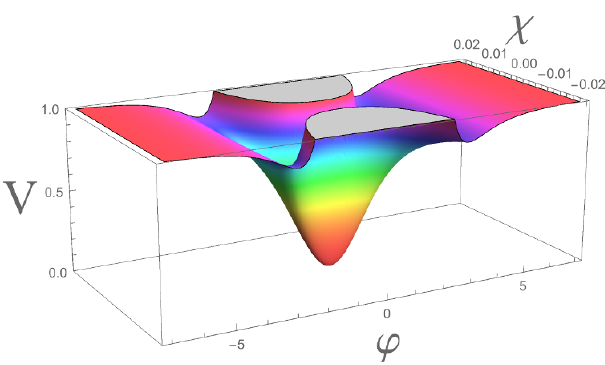
Figure 11 . A view from above on the in(cid:13)ationary potential. The red area shows the in(cid:13)ationary plateau asymptotically rising to V = m 2 . The blue lines show valleys corresponding to in(cid:13)ationary attractors with (cid:11) = 1 = 3. After the merger, they form a narrow gorge with the potential V = m 2 tanh 2 ’ , which corresponds to the T-model (cid:11) -attractor with (cid:11) = 2 = 3 shown in (cid:12)gure 12. The 2 value of the in(cid:13)aton (cid:12)eld ’ , which corresponds to the merger point, depends on the parameter M . For su(cid:14)ciently large M , the last 60 e-folds of in(cid:13)ation are described by the single attractor with (cid:11) = 2 = 3.